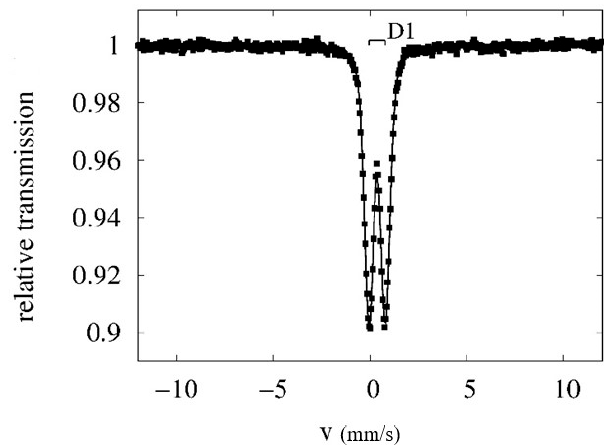
Figure 10. Room temperature (RT) Mössbauer MS spectrum of the EC solid product prepared from leachate of